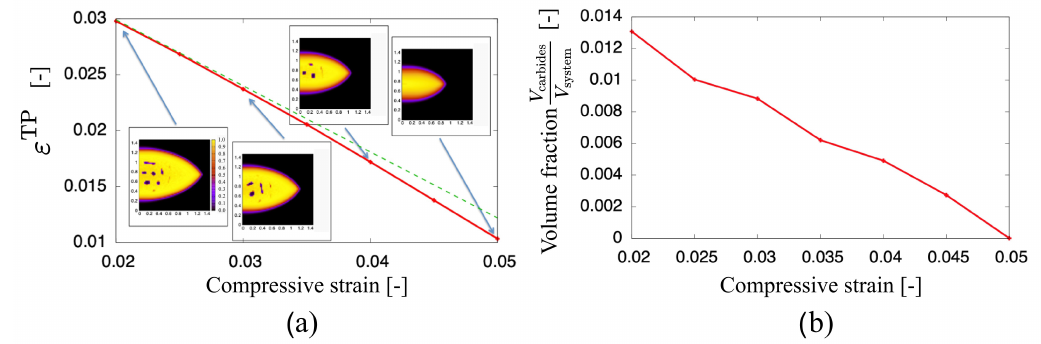
Figure 15. ( a ) Resulting transformation plasticity on the subunit level due to the application of an external compression during the bainitic transformation in a plane strain setup. During the transformation, a perpendicular compressive strain is applied in the direction perpendicular to the bainite front propagation. It is released after the process, and a remaining stress free strain (cid:101) TP is resulting from the phase transformations. The dashed line is a linear fit to the low strain data, emphasizing the nonlinear transformation plasticity at larger applied strains. The model is based here on elasticity and phase transformations only, which is a suitable description in the small strain regime. ( b ) Carbide phase fraction as function of the external compressive